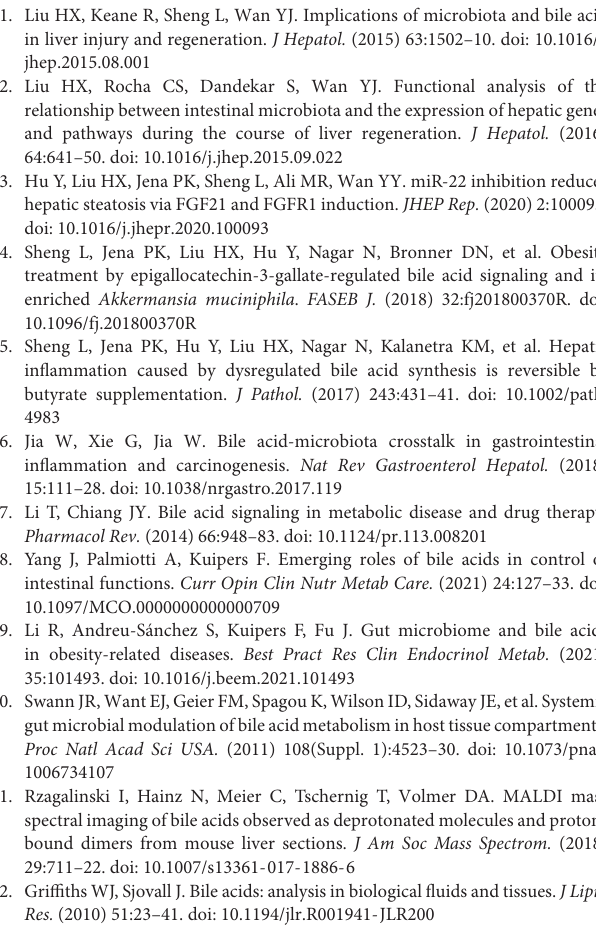
Supplementary Figure 1 | The structures and mass spectrum of NPA. Supplementary Figure 2 | Approximate values of the optimal laser intensity for each set “laser diameter” value and the diameter of the laser in that case. Supplementary Figure 3 | The structures of BAs. Supplementary Figure 4 | Imaging MS analysis of the BAs in mouse liver generated by iMScope (The scale bar is 700 µ m). Imaging MS analysis of TDCA/TCDCA/TUDCA at m/z 498.2895 ± 0.05; TCA/TMCA at m/z 514.2844 ± 0.05 with 9AA as the matrix (A) . Imaging MS analysis of